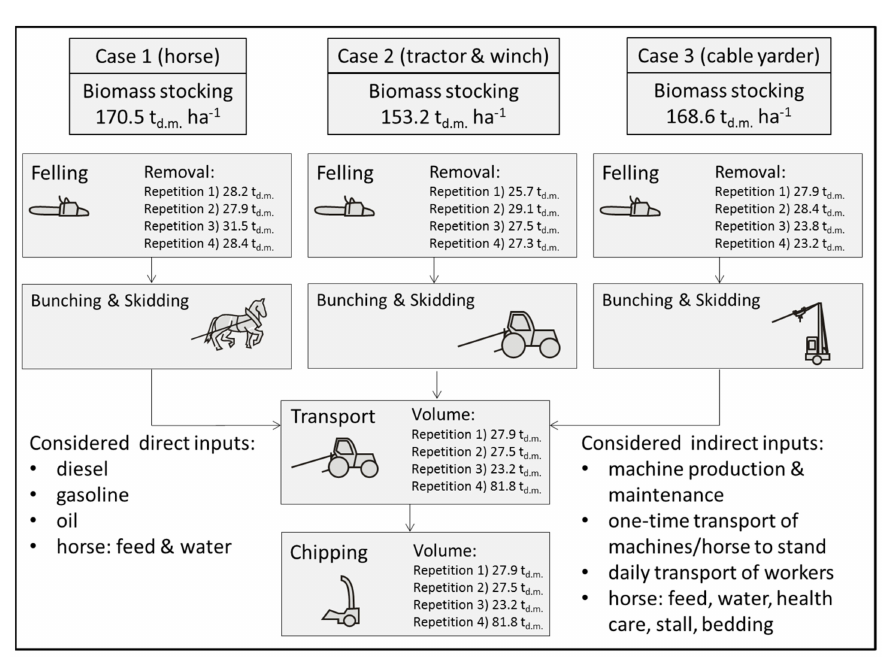
Figure 1. Schematic presentation of the four analyzed forest wood chains that di ff er in the extraction processes and amount of biomass removal, in tons dry matter (t d.m.